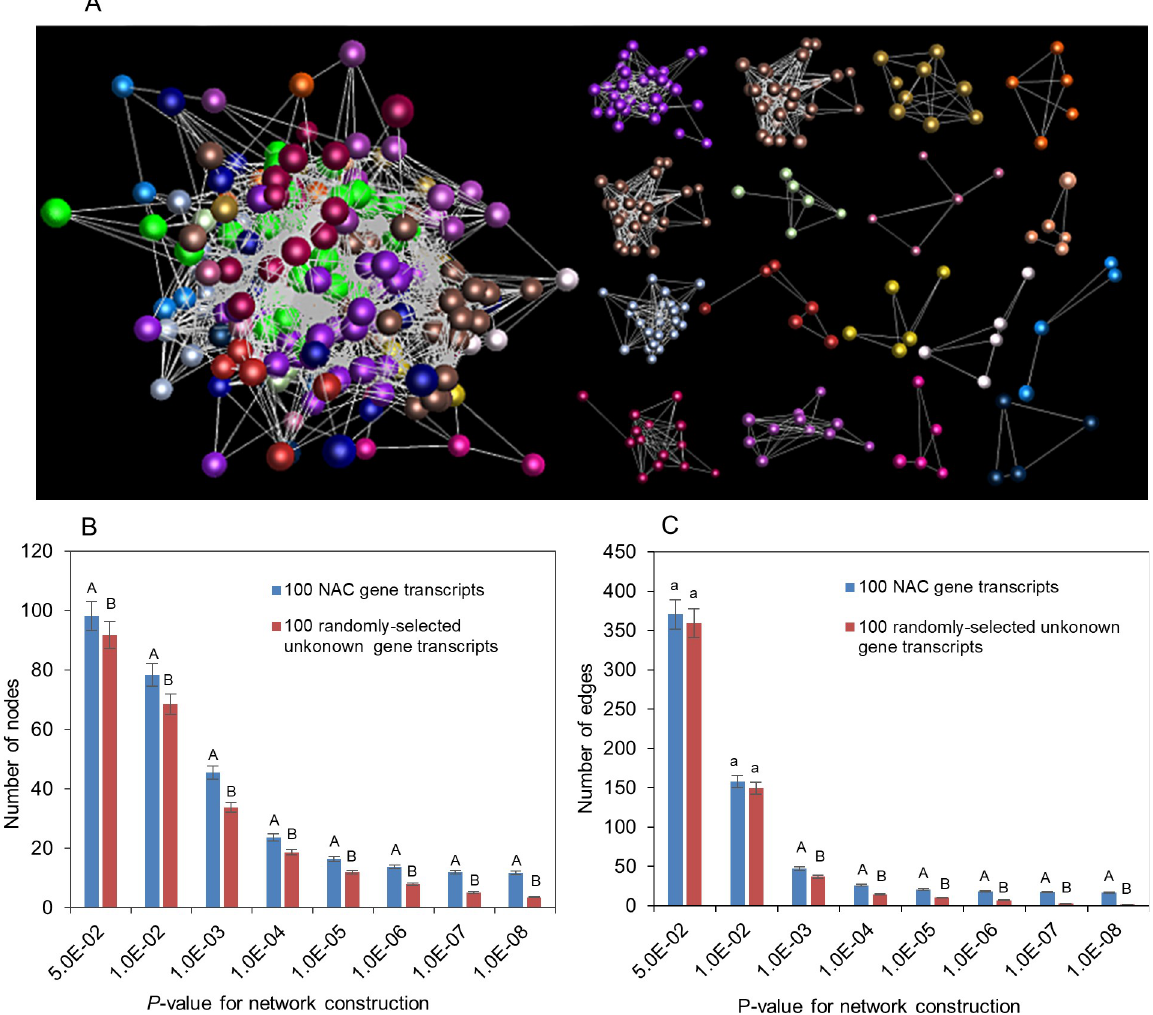
Fig 8. Co-expression network of the PgNAC transcripts in 14 tissues of a four-year-old plant. These 14 tissues were collected at the fruiting stage of the plant. (A) The co-expression network and its clusters constructed from 226 of the 251 PgNAC transcripts at P � 5.0E-02. The network consisted of 226 PgNAC transcript nodes and 1,935 transcript co-expression edges. (B) Statistics of the tendency of the PgNAC transcripts forming a co-expression network: number of nodes. (C) Statistics of the tendency of the PgNAC transcripts forming a co-expression network: number of edges. The 100 PgNAC transcripts were randomly selected from the 251 PgNAC transcripts identified in this study by bootstrap sampling, with 10 replications, while the 100 randomly-selected unknown transcripts were randomly selected from Database A [17]. Different capital letters indicate that the difference is significant at a two-tailed significance of P � 0.01. The same small letters indicate that the difference is not significant at a two-tailed significance of P � 0.05.